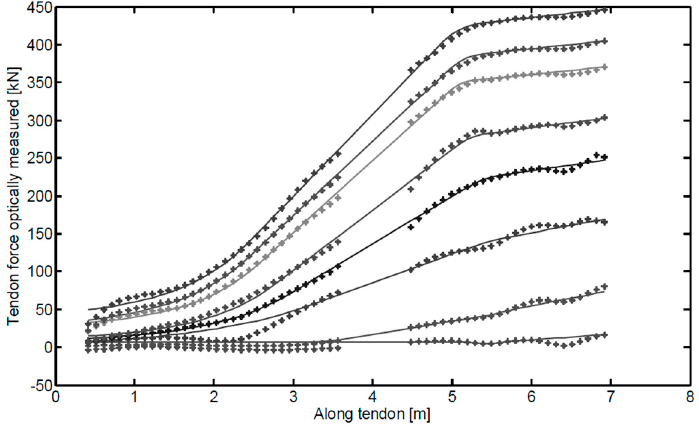
Figure 15. Load distribution measured by the Brillouin scattering sensing technique at different load steps